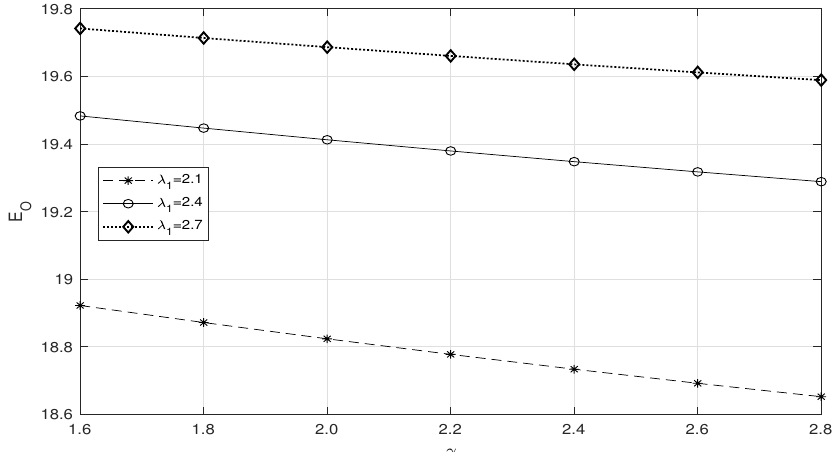
Figure 1. Mean number of customers in the orbit on λ 1 vs. γ .